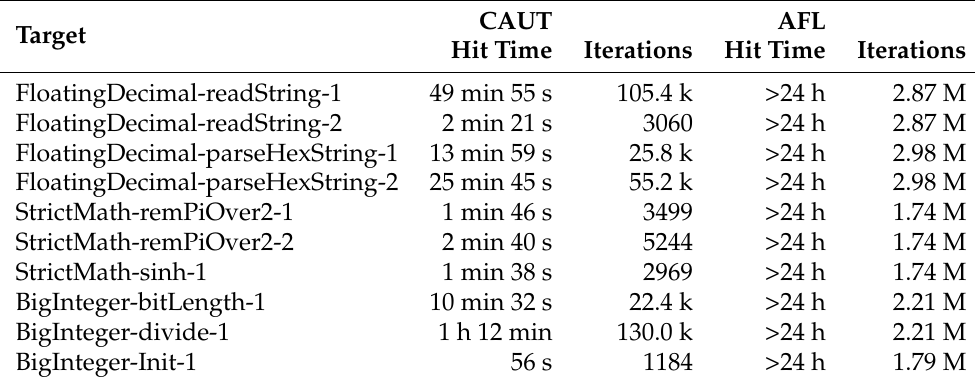
Table 3. Results of CAUT on 10 target program paths not hit by AFL within 24 h.